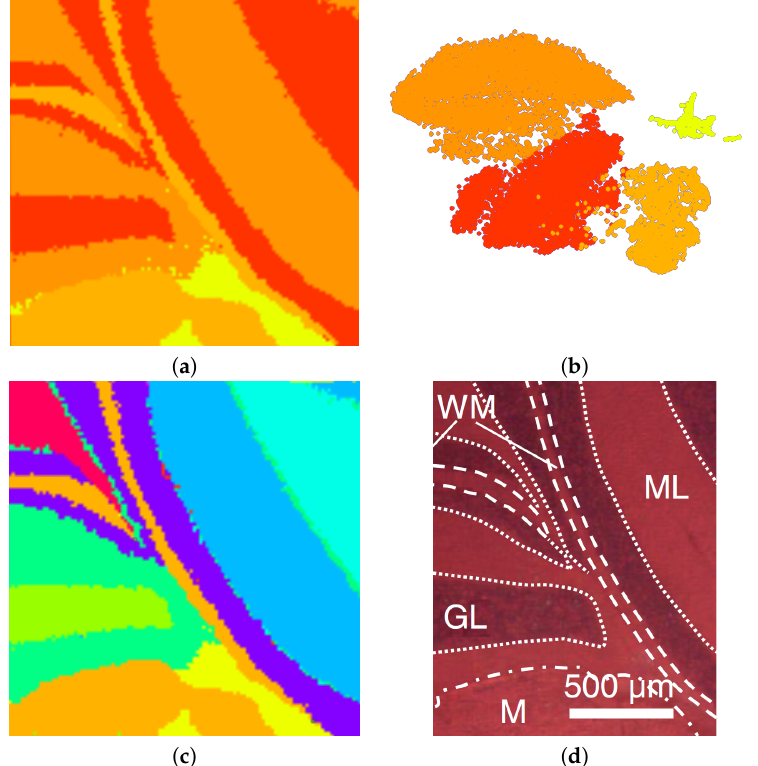
Figure 11. Mouse cerebellum in negative ion mode data set [9]: Interactive selection of clusters in non-linear embedding ( b ) reveals image regions ( a ) close to ground truth ( d ). Further interactive cluster refinement delivered an enhanced result ( c